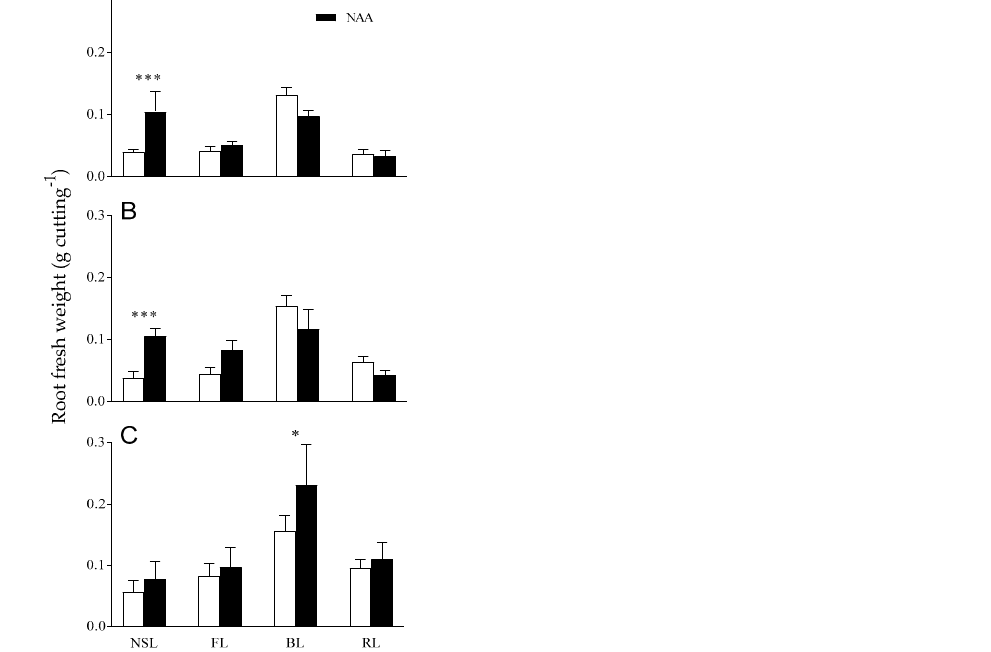
Figure 4. NAA treatment effects on root growth of ( A ) apical-, ( B ) middle-, and ( C ) basal-position rosemary cuttings treated natural sunlight (NSL), fluorescent lamp light (FL), blue light (BL), and red light (RL) for 4 weeks. Error bars indicate the mean ± SE from three replications (n = 8). Asterisks over bars indicate significant differences between non-NAA and NAA treatments at p < 0.05 (*) and <0.001 (***).